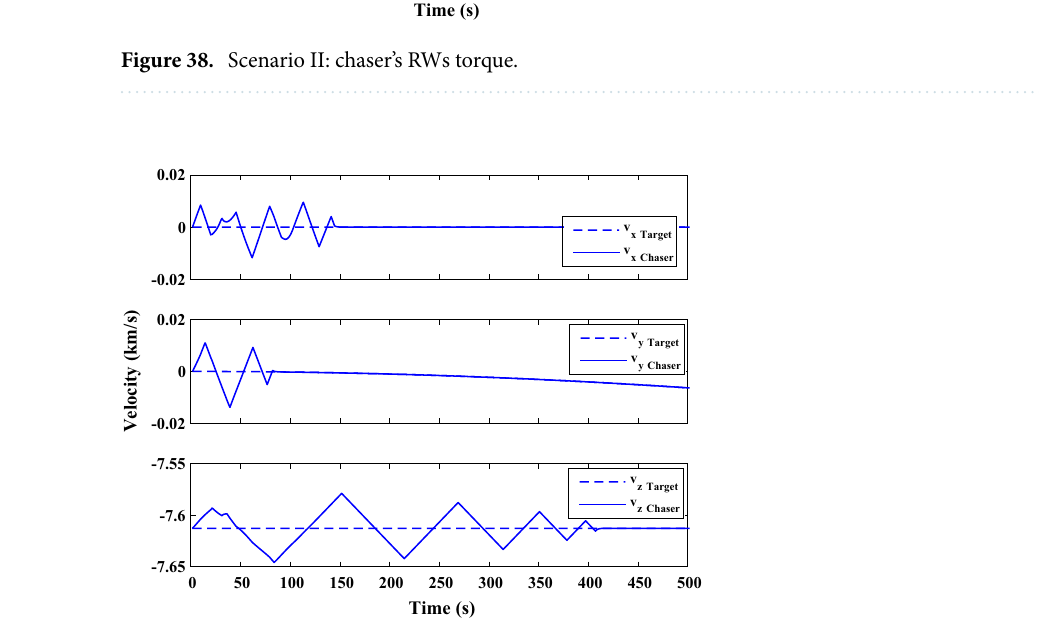
Figure 39. Scenario II: linear velocity tracking (in desired